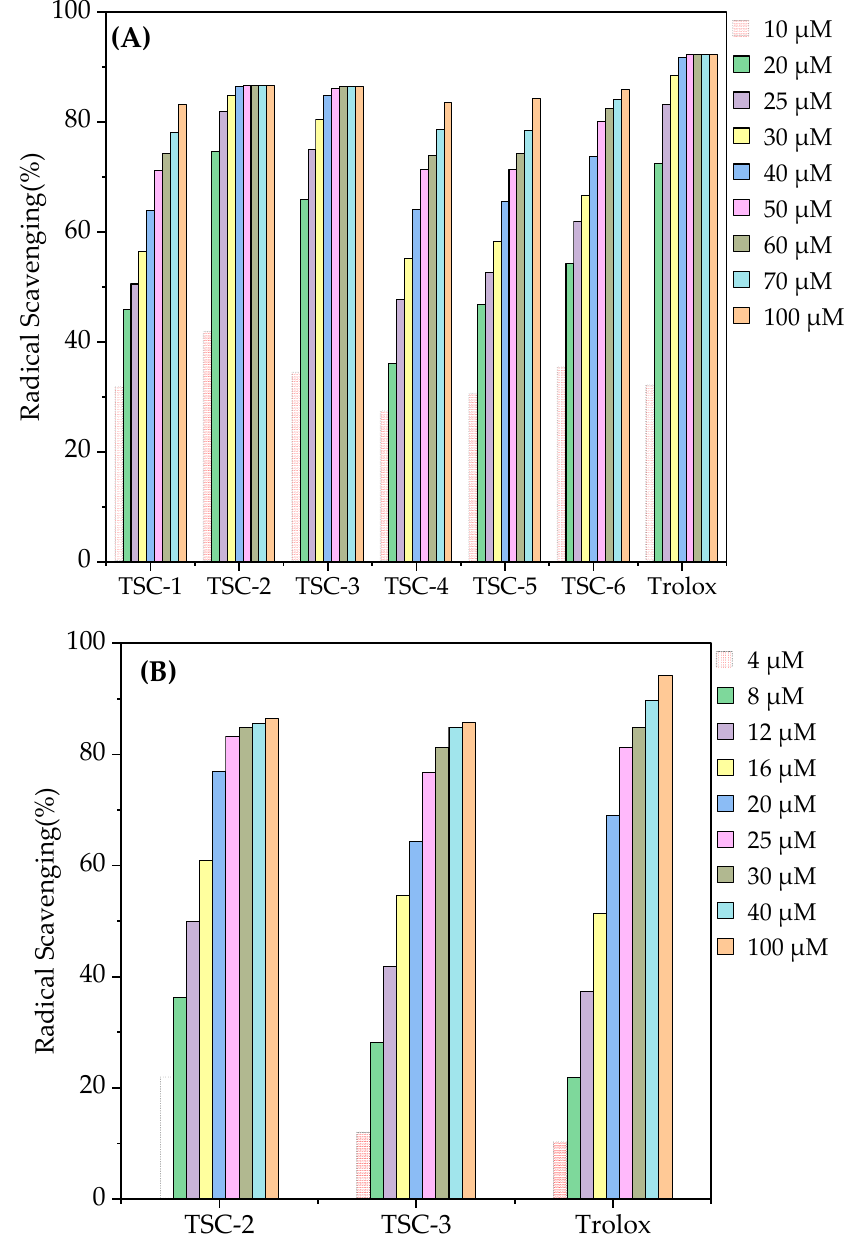
Figure 2. ( A ) 2,2-diphenyl-1-picrylhydrazyl (DPPH) radical scavenging capacity (%) of Figure 2. ( A) 2,2-diphenyl-1-picrylhydrazyl (DPPH) radical scavenging capacity (%) of the camphene- the camphene-based thiosemicarbazone compounds ( TSC-1~6 ) at di ff erent concentrations (10~100 µ M); based thiosemicarbazone compounds ( TSC-1~6 ) at different concentrations (10~100 µM); ( B) DPPH ( B ) DPPH radical scavenging capacity (%) of compounds TSC-2 , TSC-3 , and Trolox at di ff erent radical scavenging capacity (%) of compounds TSC-2 , TSC-3, and Trolox at different concentrations concentrations (4~100 µ (4~100 µM).